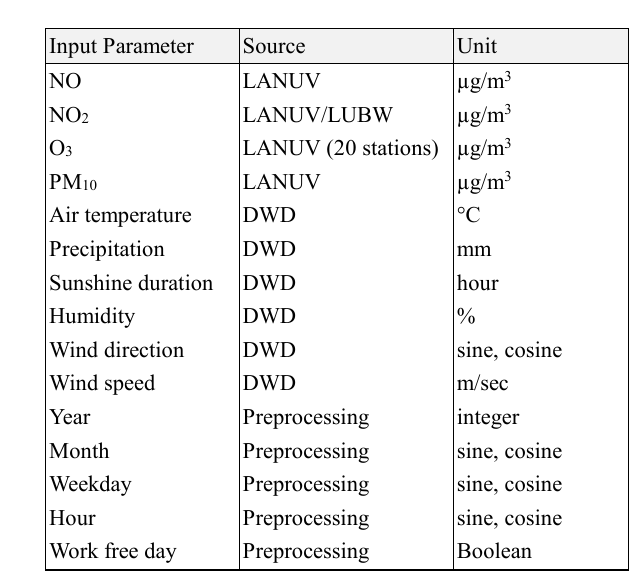
Table 1. Input parameters for